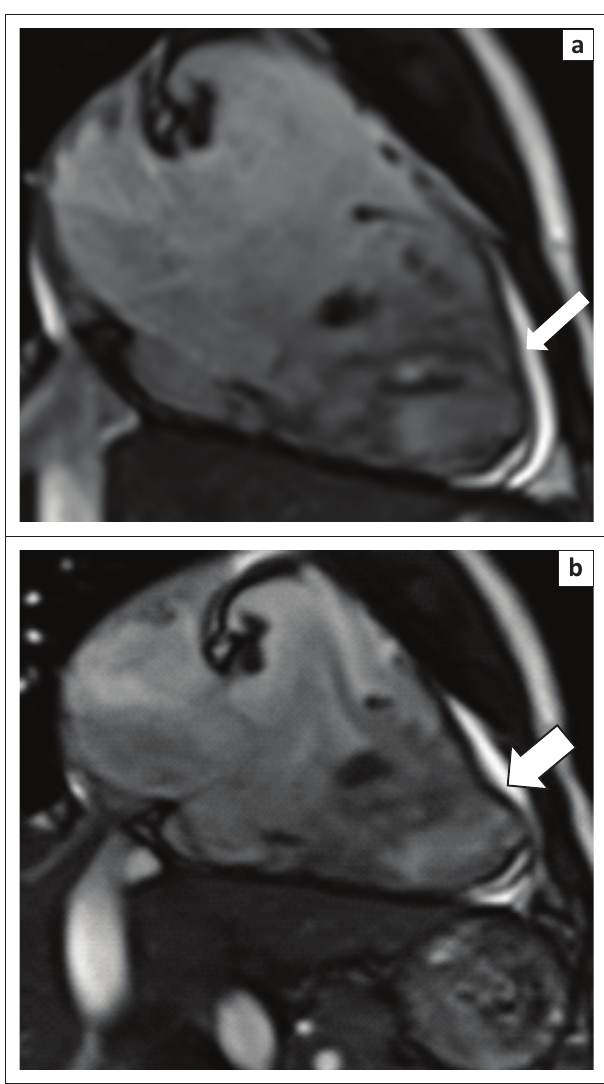
FIGURE 4: Arrhythmogenic right ventricle cardiomyopathy. RV two-chamber views cine b-SSFP in end-diastole (left) and end-systole (right) demonstrating a dyskinetic RV apex (arrows).